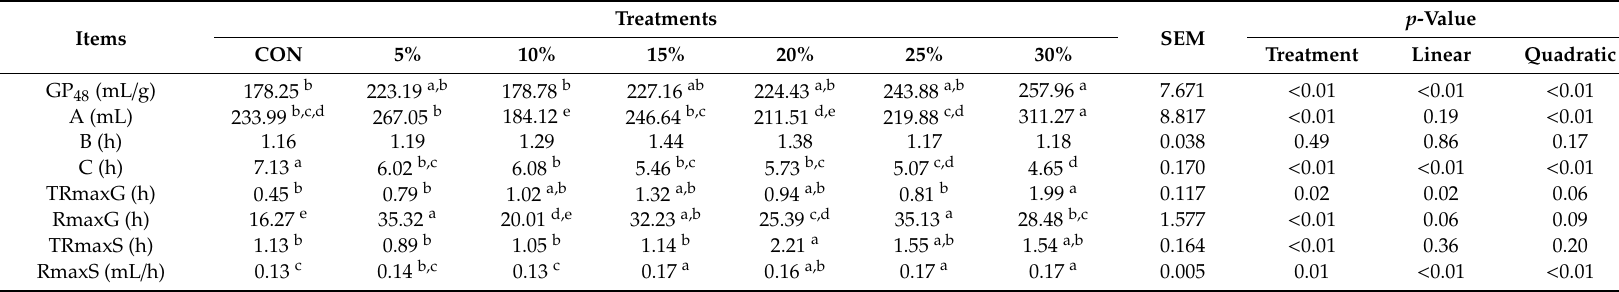
RmaxS (mL / h) 0.13 c 0.14 b,c 0.13 c 0.17 a 0.17 a 0.005 0.01 < 0.01 <